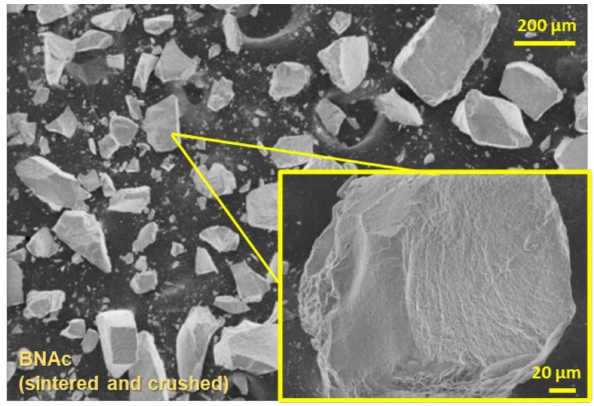
Figure 3. BNAc powder SEM